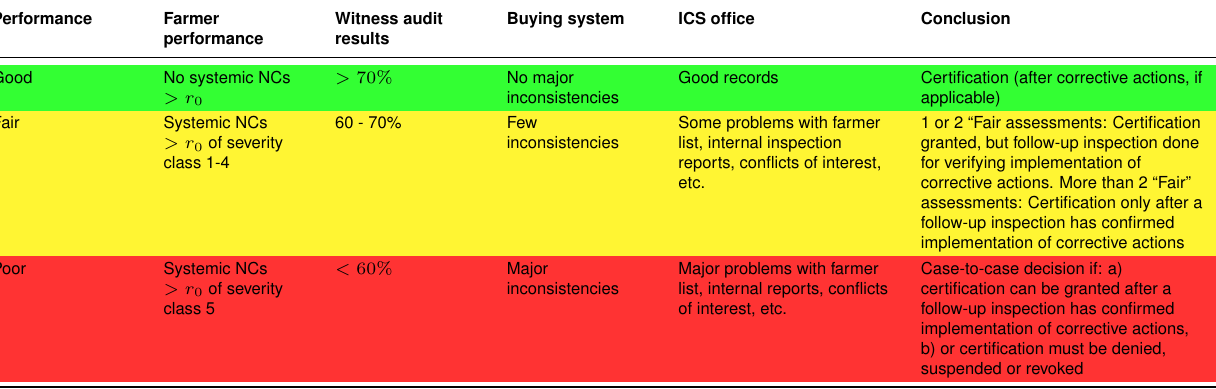
Table 8. Traffic light system for ICS performance from different inspection levels in a group certification